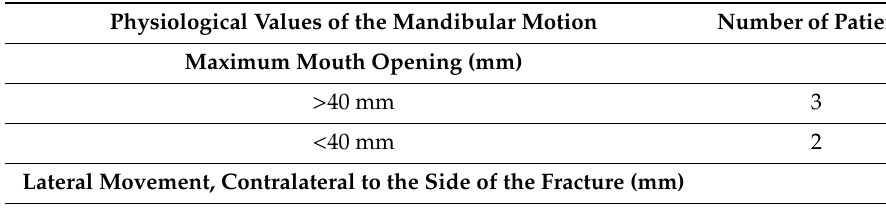
Table 4. Post-operative mandibular motion values in the unilateral condylar fractures. Results are three months post-treatment.